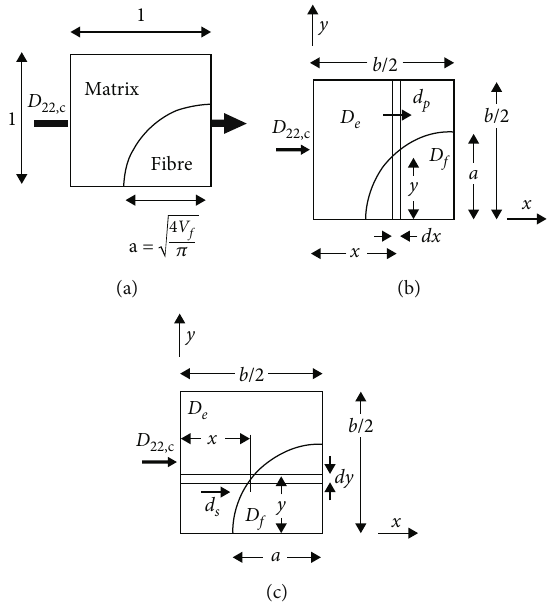
Figure 2: (a) Repeating element of a composite used in the Keller-Sachs, SP, and PS models, (b) Parallel-series (PS) approximation and (c) series-parallel (SP) approximation to the transverse di ff usivity of a composite